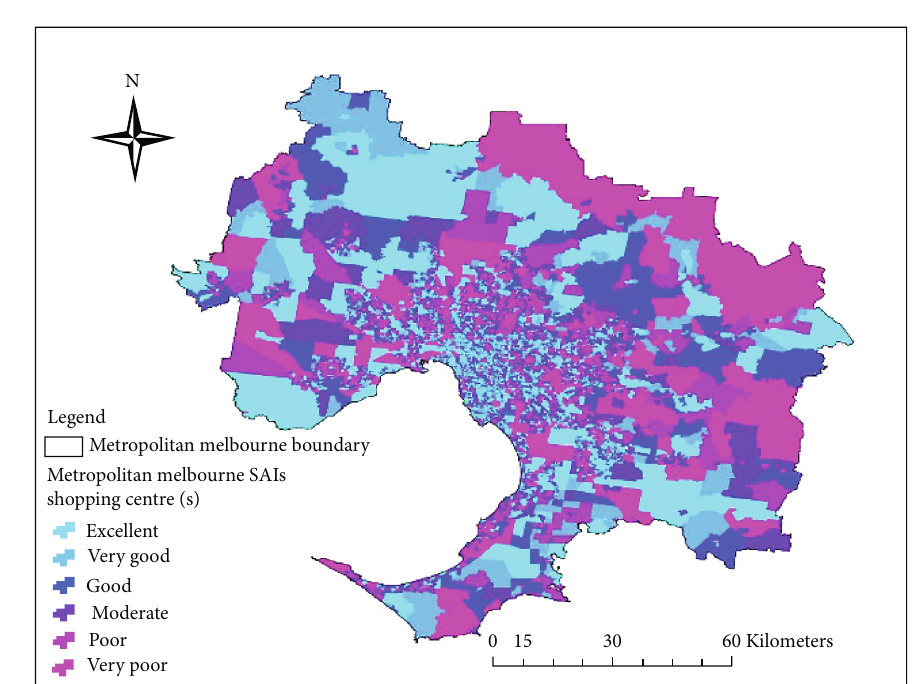
Total analyzed SA1s = 10,289 .